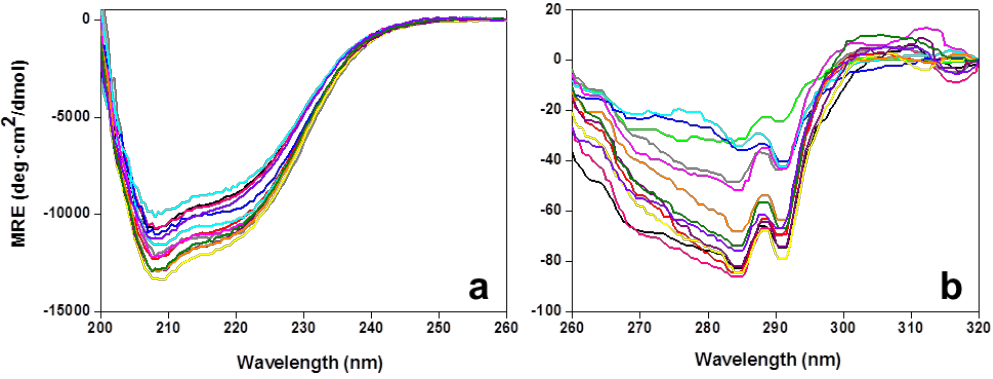
Figure S2. Circular dichroism spectra (molar ellipticity per residue) in the ( a ) far-UV (5 µM Ca FADS in 5 mM PIPES, 10 mM MgCl , pH 7.0 in a 0.1 cm path length cuvette) 2 and ( b ) near-UV (20 µM Ca FADS in 20 mM PIPES, 10 mM MgCl , pH 7.0 in a 0.4 cm 2 path length cuvette) regions for WT (black), H28A (pink), H28D (red), H31A (green), H31D (grey), N125A (blue), N125D (cyan), R161A (magenta), R161D (yellow), S164A (purple), S164D (orange), T165A (dark green) and T165D (violet).